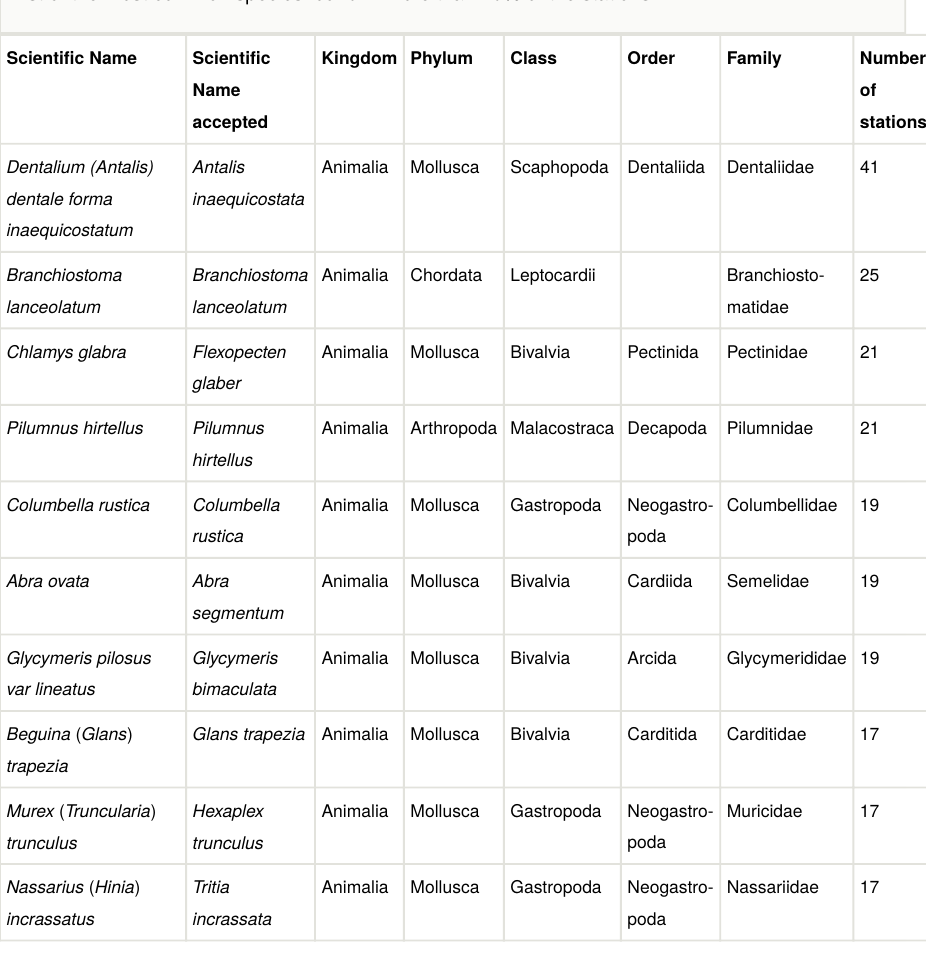
Table 3. List of the most common species found in more than 10% of